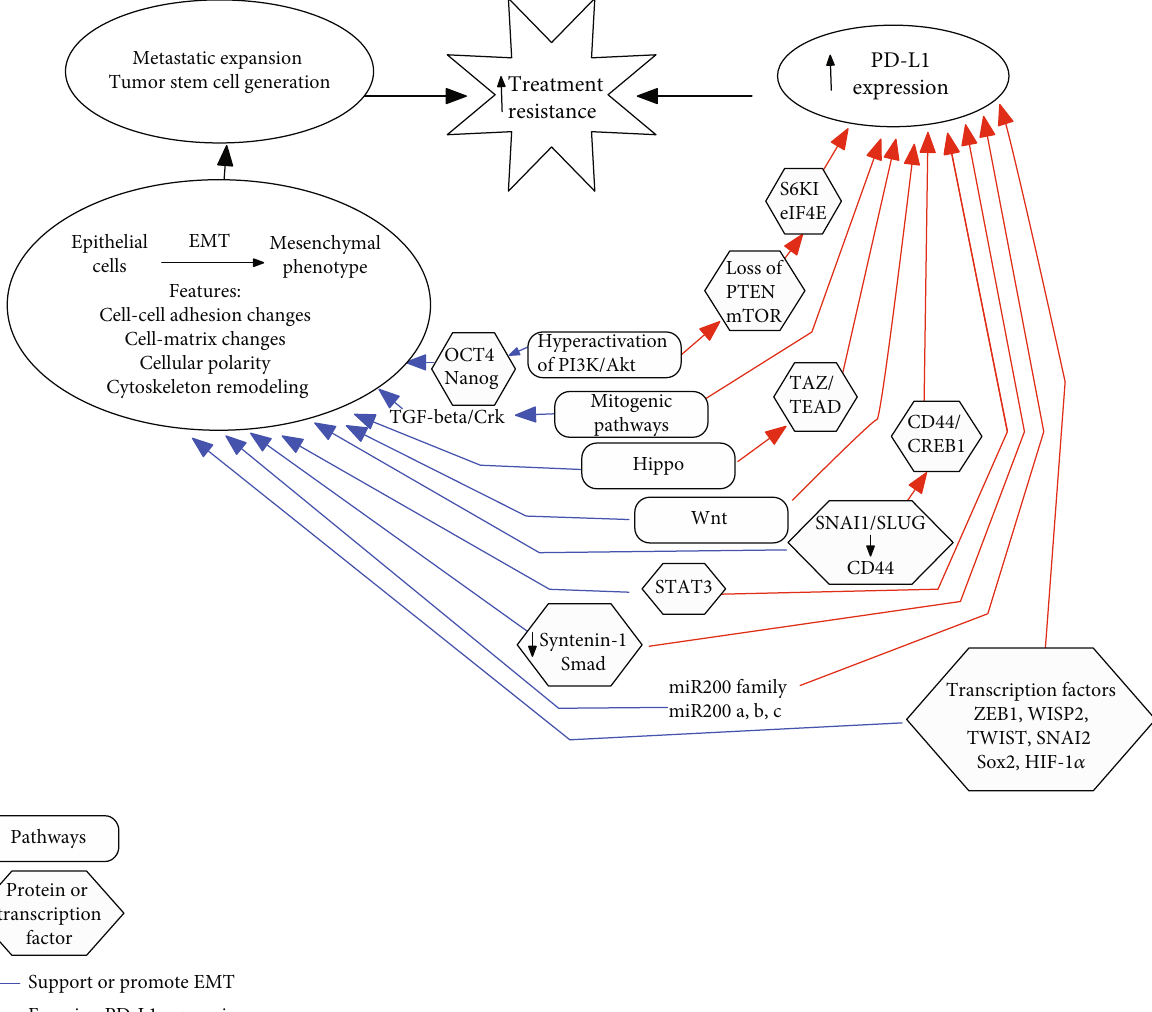
Figure 1: Signaling pathways and transcription factors that interconnect EMT and PD-L1 expression causing increase in PD-L1 expression and consequently failure of immune therapy in breast